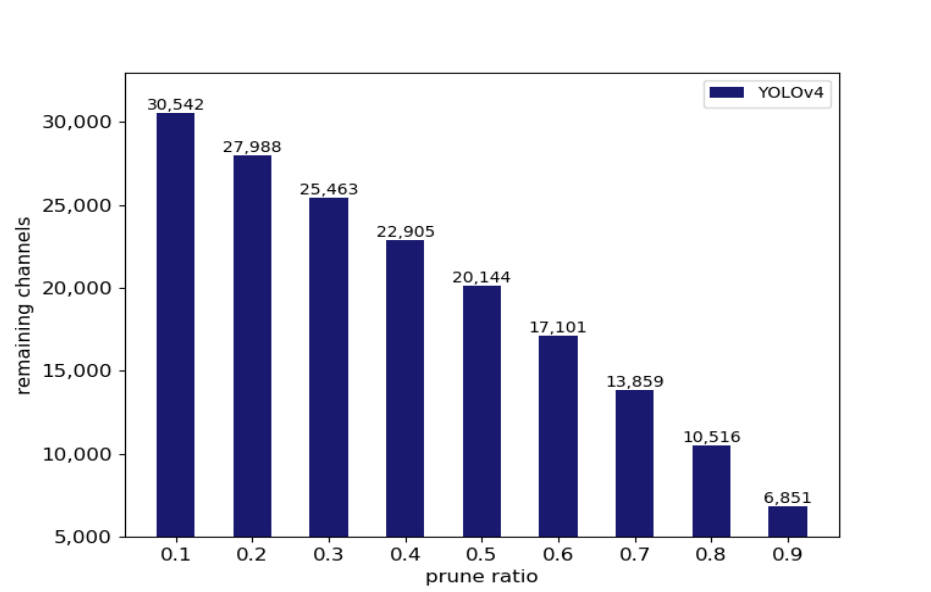
Figure 10. Number of channels remaining in the model with different pruning ratios.